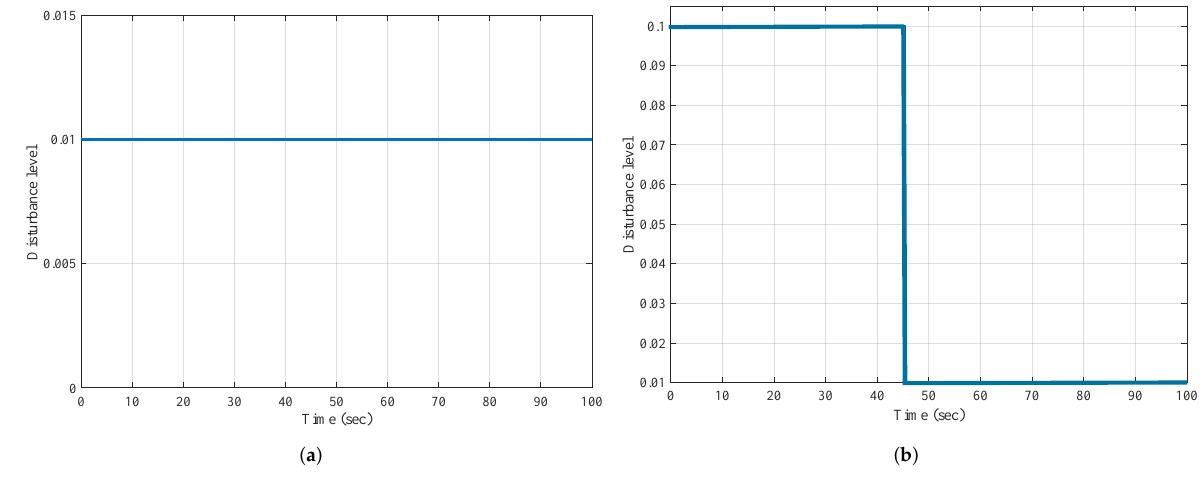
Figure 14. The conducted disturbance on area 2: ( a ) step of 1% and ( b ) variable step disturbance. The time responses of frequency perturbations, ∆ F 1 , ∆ F 2 , ∆ F 3 , and ∆ F 4 , and tie-line powers, ∆ P tie 2 , ∆ P tie 2 , ∆ P tie 3 , and ∆ P tie 4 , achieved via the proposed approach and the